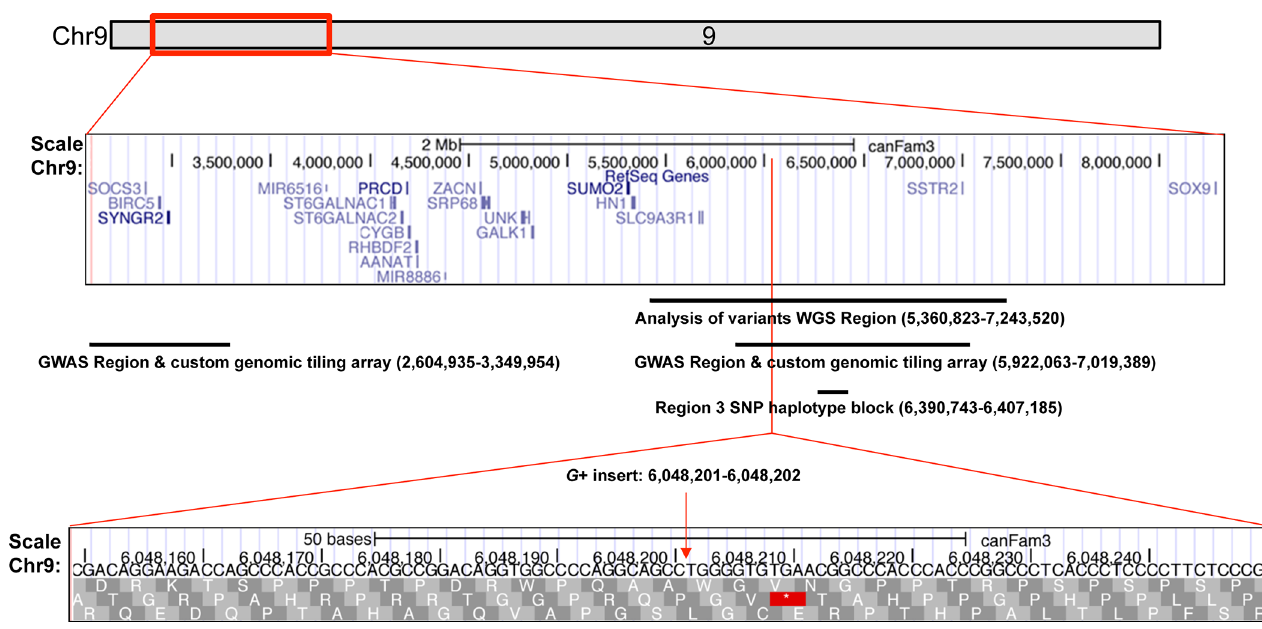
Fig 2. Genomic regions on CFA9 associatedwith canine XX DSD, indicated by method of identification. The top ideogramof CFA9 (UCSC browser, CanFam 3/3.1) shows the entire span in which regionsassociatedwith canine XX DSD were found in this study. Red lines indicate magnifiedportions of this span, which are screen shots from the browser. Horizontalbars approximate the location of each regionidentified.Text belowthe bars indicatesthe method by which a regionwas identified,and its specific coordinates. The bottom screen shot shows the locationof the G+ insert (arrow) associatedwith canine XX DSD.